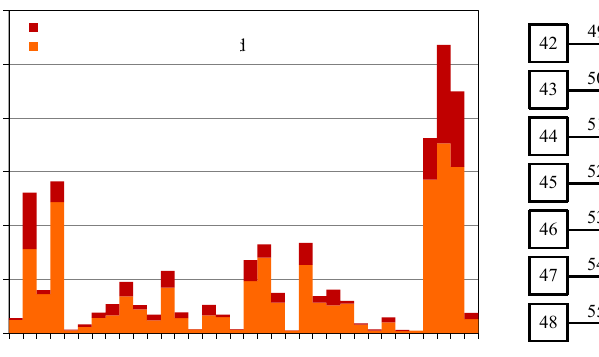
Fig. 2. Heat loads of united consumers of the DHS of Shelekhov city.